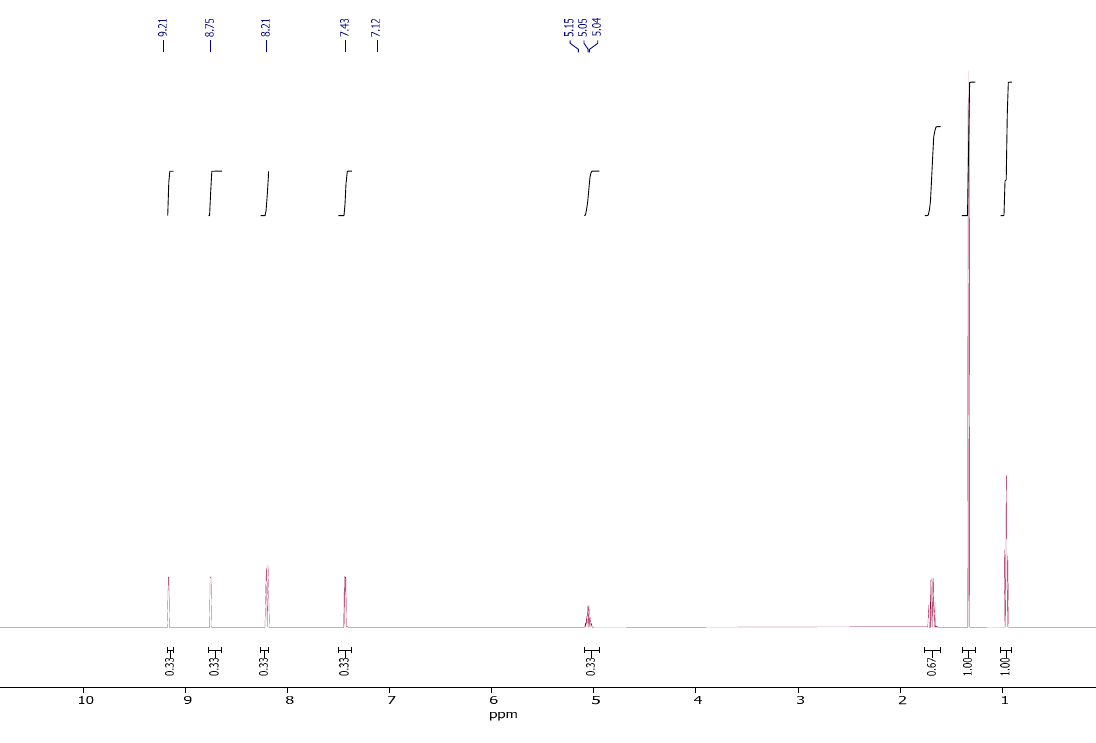
Figure 1. 1 HNMR spectrum of NA-PVA copolymer